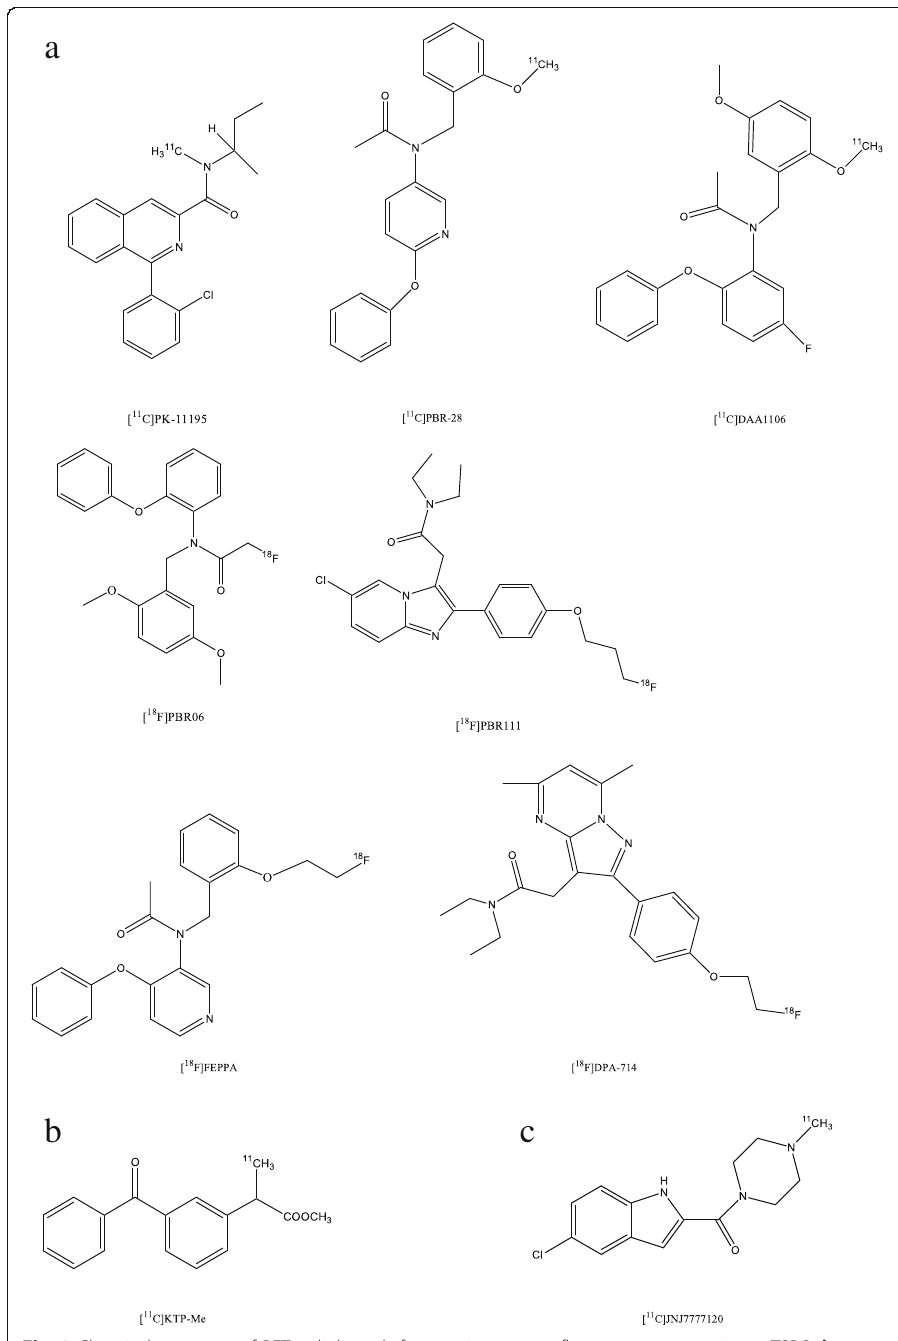
Fig. 3 Chemical structures of PET radioligands for imaging neuroinflammation – targeting: a TSPO, b cyclooxygenase 1 and c histamine 4